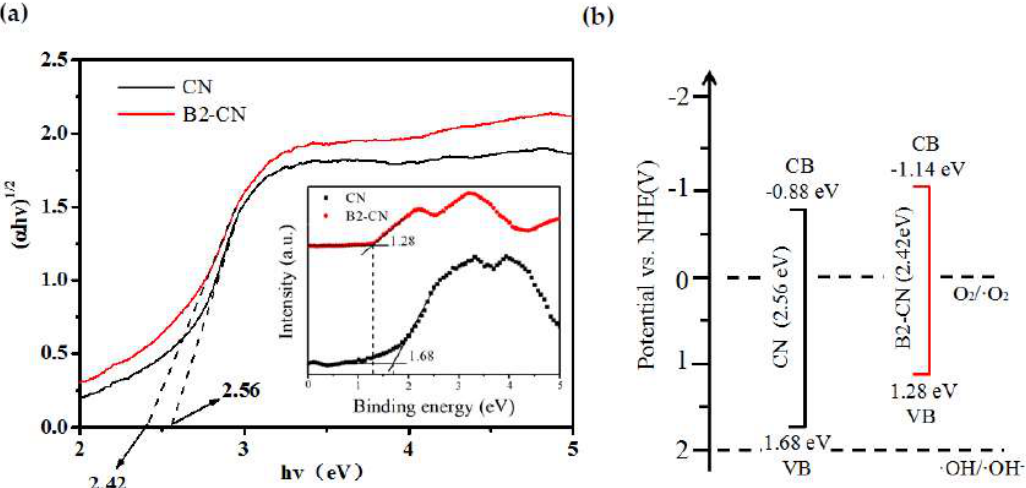
Figure 6. ( a ) indirect electron transitions and VBXPS (inset) of CN and B2-CN; ( b ) the determined CB and VB edges of CN and B2-CN.